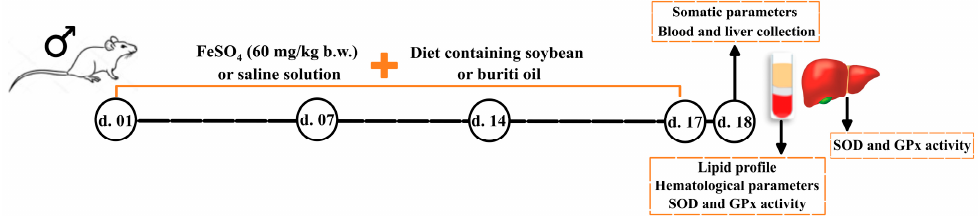
Figure 6. Timeline and steps of study design. B.W. = body weight; d. = day; GPx = glutathione peroxidase; SOD = superoxide dismutase.